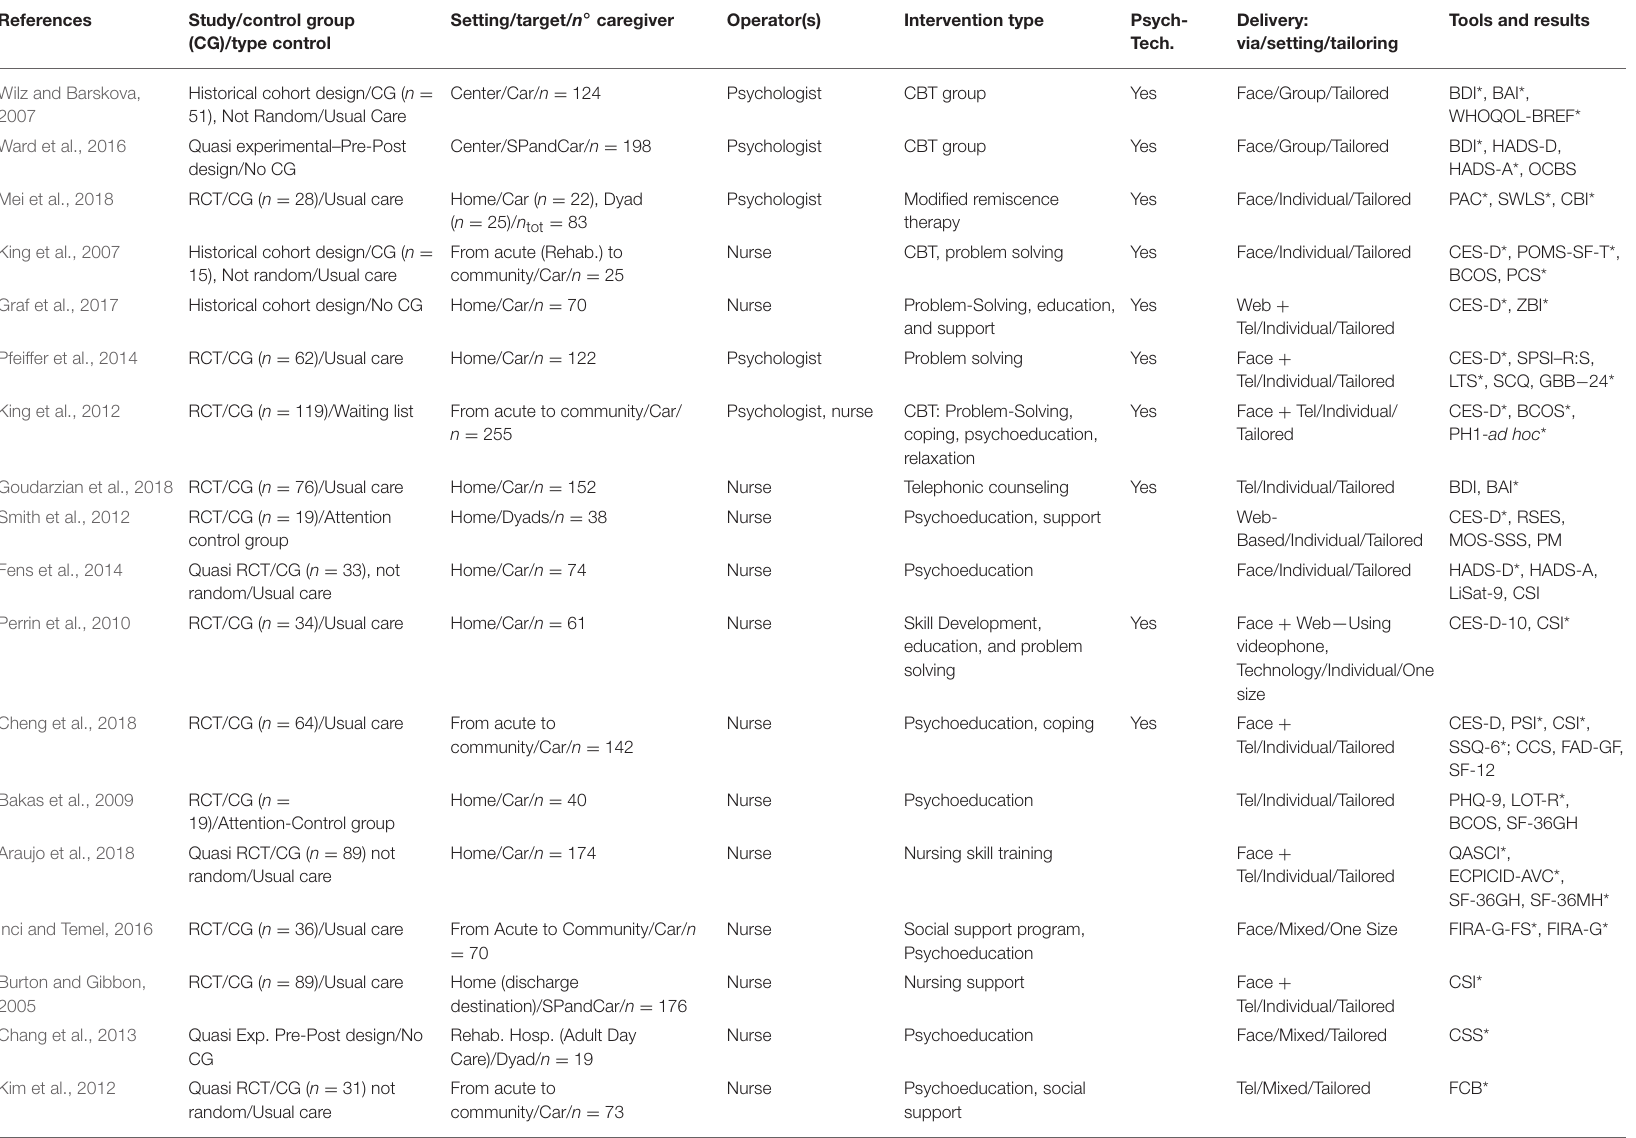
TABLE 1 | Characteristics and results of the 45 studies ordered by relevance of positive psychological outcomes